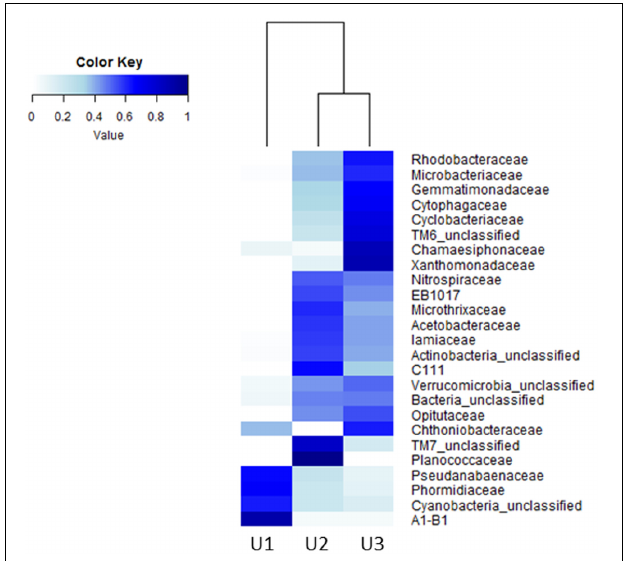
FIGURE 4 | Heatmap generated by using the “heatmap.2” function in R package to show the microbial compositions of the top 25 taxa at family level in U1, U2, and U3 of a conical microbial mat from Lake Untersee, Antarctica. The rows indicate the bacterial taxa and the columns represent the three mat laminae used in this